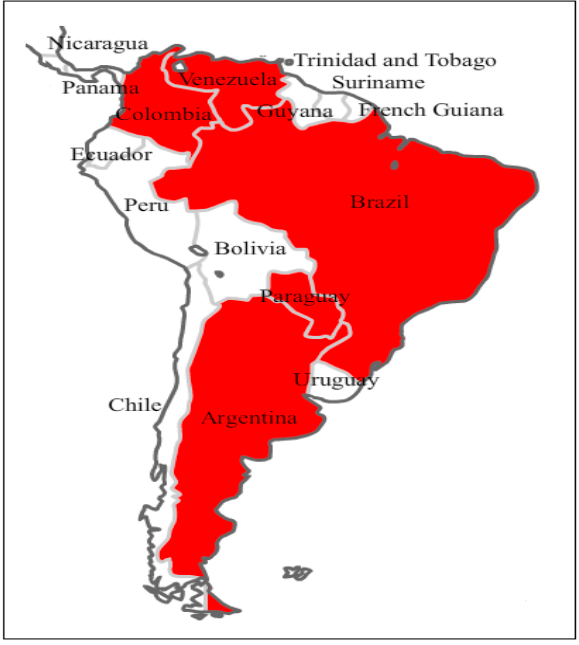
Figure 1. Countries of South America where S. rebaudiana grows spontaneously.